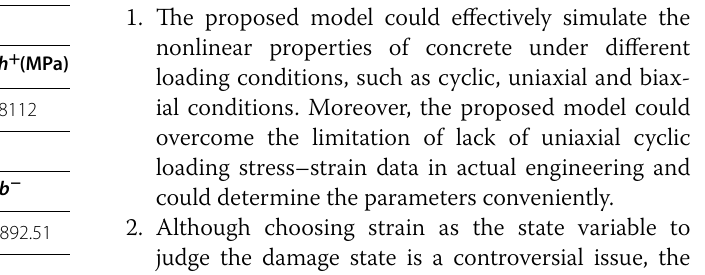
recovery due to crack closure in cyclic loading. With